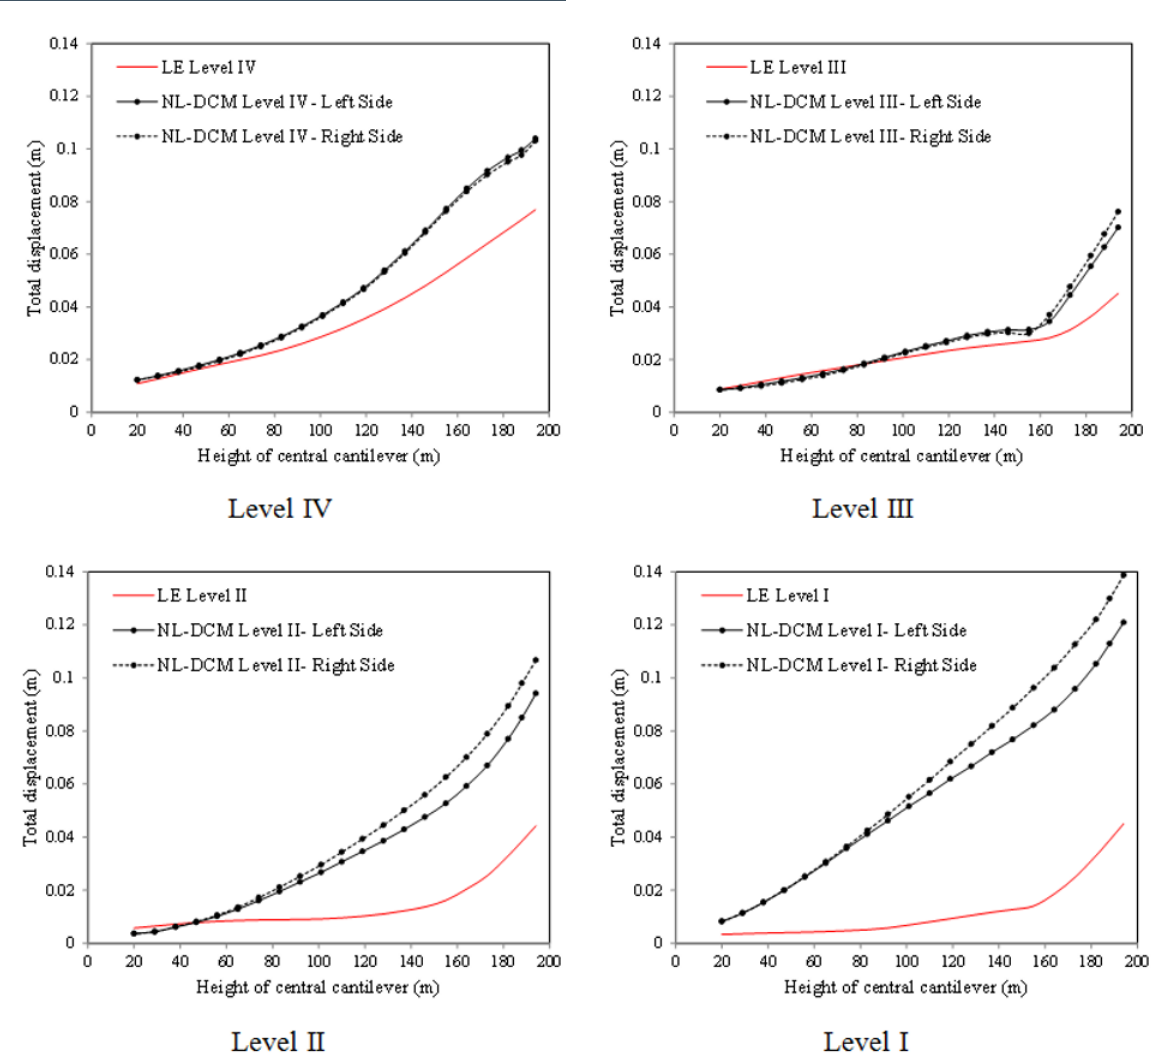
Figure 22. Comparing non-concurrent envelopes of displacement along the central cantilever for LE and